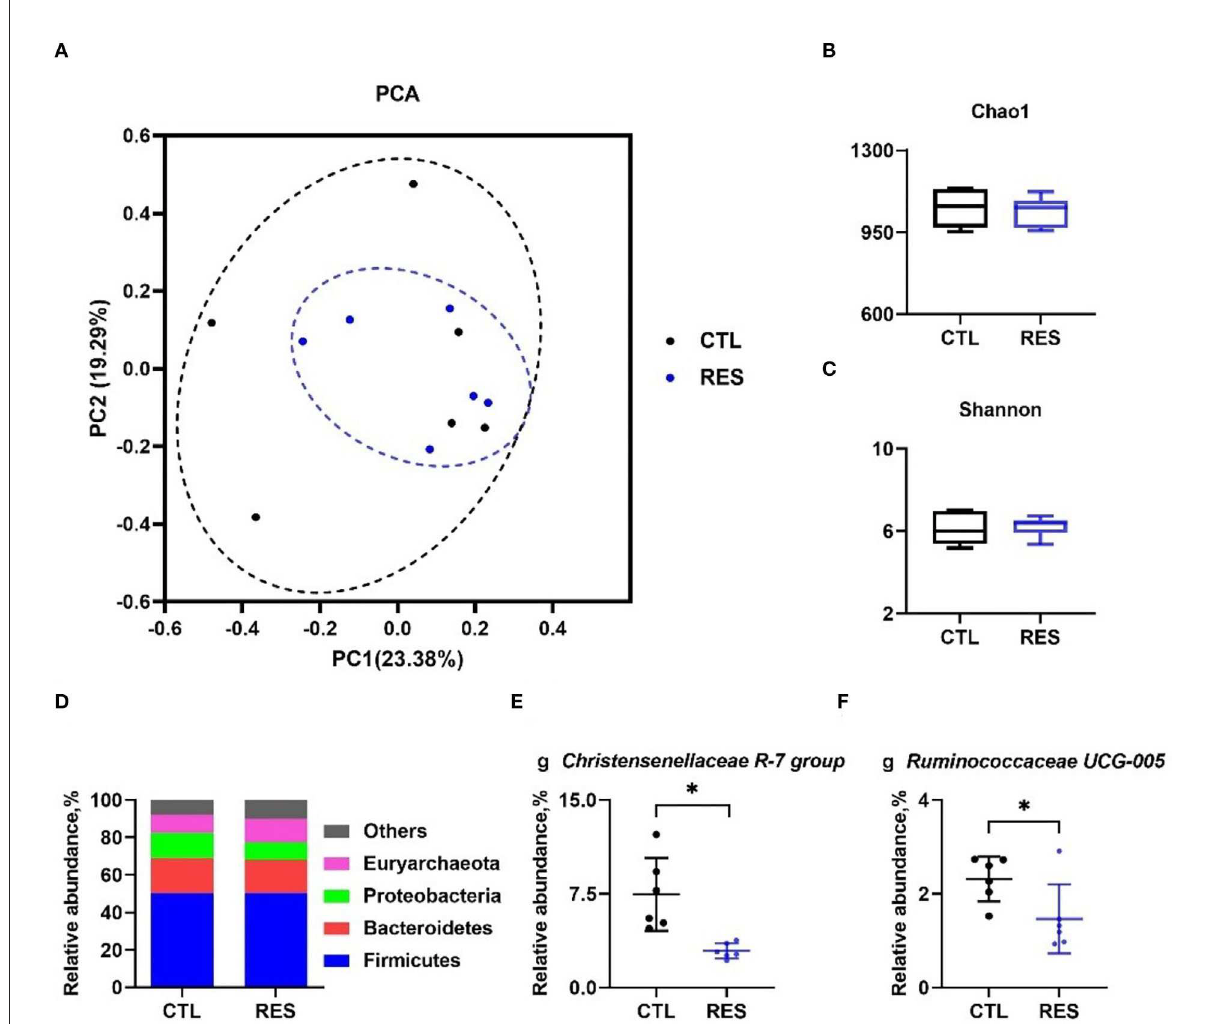
FIGURE5 Modulation of the gut microbiota by RES. The effect of RES on genus-based ( n = 6) principal component analysis (PCA) (A) , the Chao 1 index (B) , the Shannon index (C) , the effect of RES on the relative abundance of main microbes at the phylum level (D) and the genera Christensenellaceae R-7 group (E) , and Ruminococcaceae UCG-005 (F) . CTL, a basal diet; and RES, a basal diet containing 200 mg/kg resveratrol. Data are expressed as mean ± SD ( n = 6); and *, p <